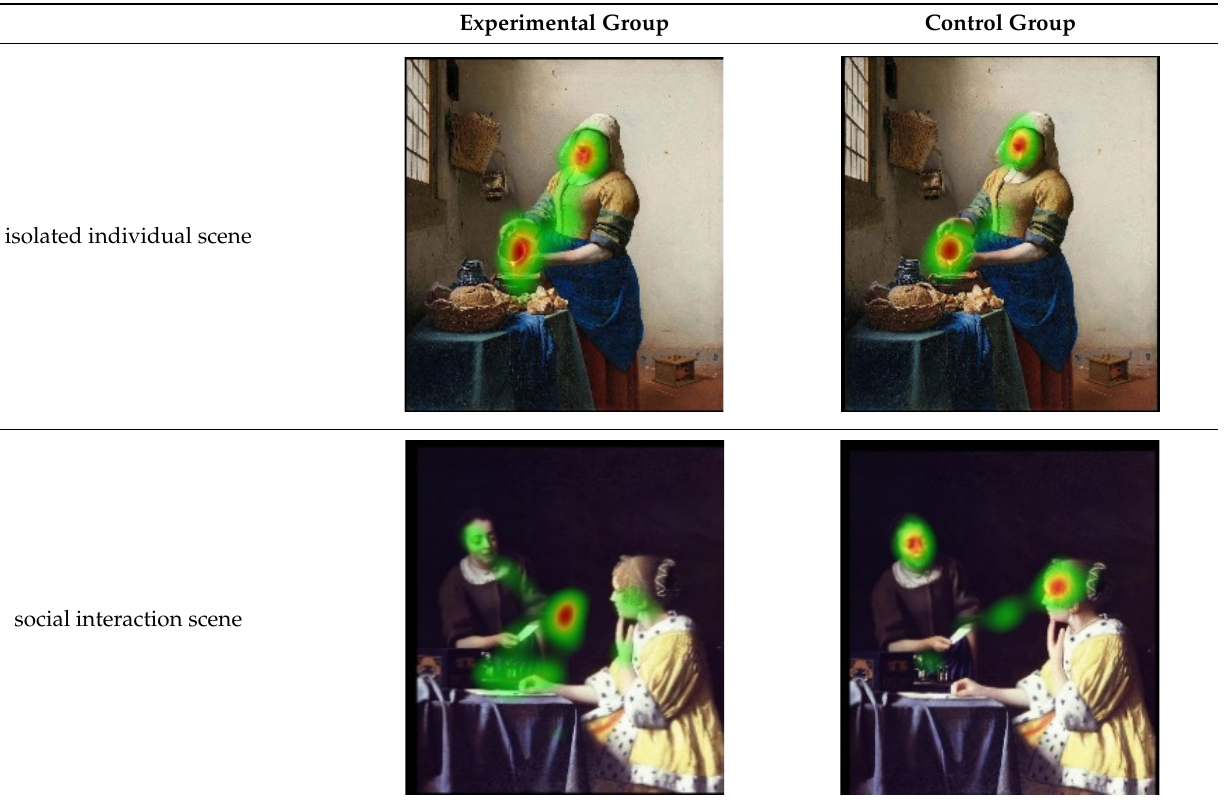
Table 5. Eye tracking diagrams of experimental group (autistic children) and control group (TD children) looking at different scenes.